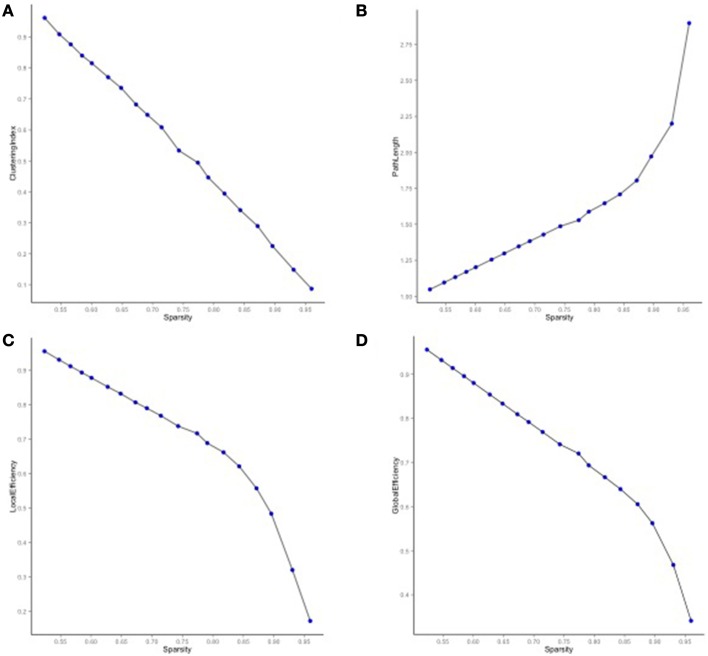
Network properties for SA and CT using different p-value thresholds as a function of sparsity degree. (A) The clustering index decreased as sparsity degree increased. (B) The characteristic path length increased as sparsity degree increased. (C) Local and (D) global efficiency decreased as sparsity increased.